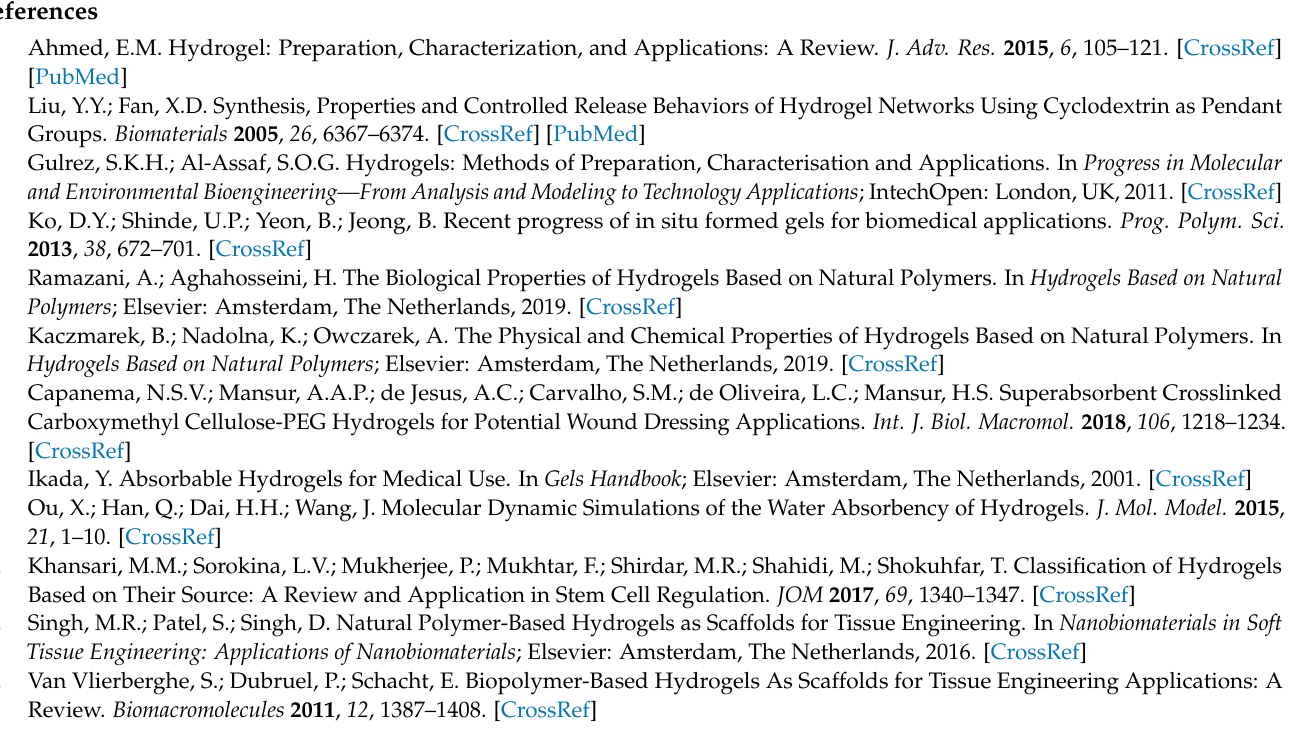
Figure S5: Conductivity of hyaluronic acid/spider silk-based hydrogels at different component ratios; Figure S6: Enzymatic degradability of hyaluronic acid/spider silk-based hydrogels at different component ratios; Figure S7: Antimicrobial ability of hyaluronic acid/spider silk-based hydrogels at different component ratios; Figure S8: Cytotoxicity of the